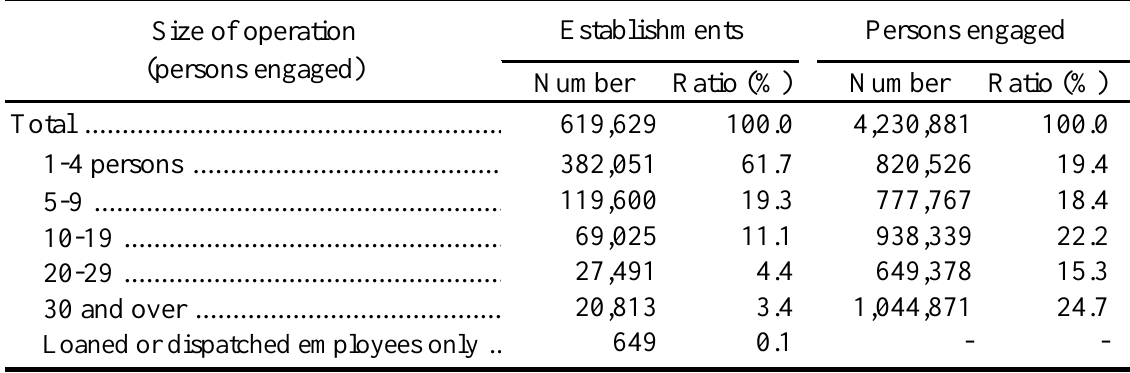
Eating and Drinking Places